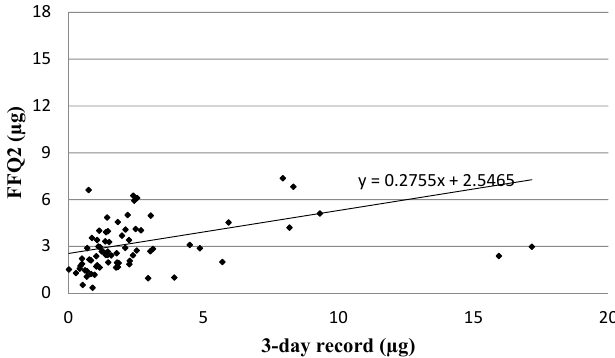
Figure 2. Analysis of correlation between VIDEO-FFQ2 and the three-day dietary record for Vitamin D daily intake (Spearman rank correlation coefficient; p < 0.01, R = 0.5025). FFQ2—VIDEO-FFQ filled out six weeks after FFQ1.